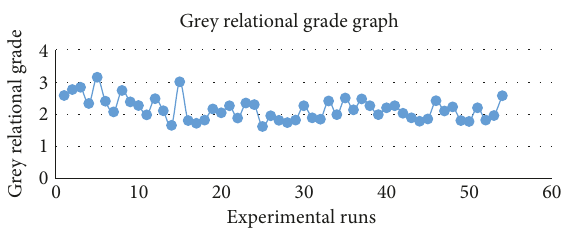
Figure 12: Grey relational grade versus experimental